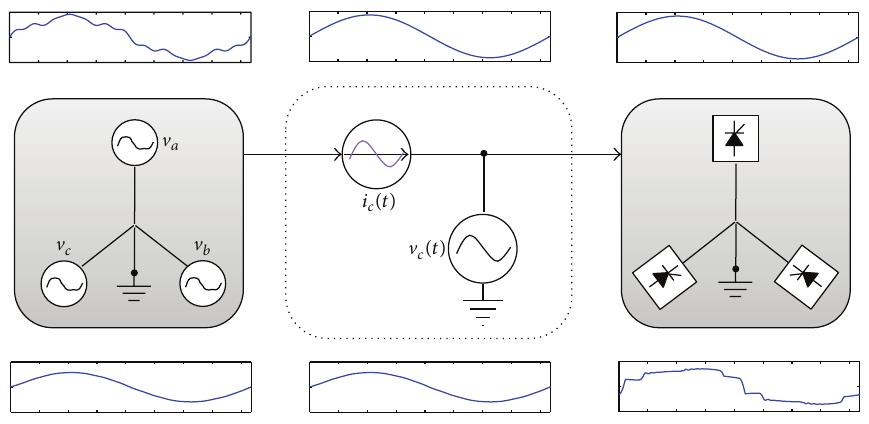
Figure 2: Dual scheme of compensation with the